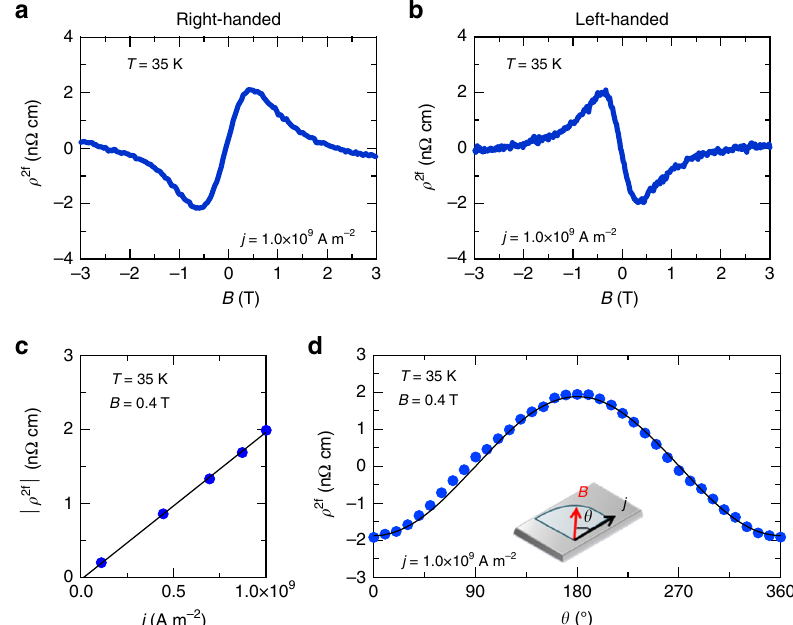
Fig. 2 Electrical magnetochiral effect in MnSi thin plate samples. a , b Magnetic fi eld dependence of second harmonic resistivity ( ρ 2f ) in right-handed a and left-handed MnSi crystals b . c , d Current-density ( j ) dependence of ρ 2f c and angle ( θ ) dependence of ρ 2f d in left-handed MnSi. Here θ is the angle between current and the magnetic fi eld as shown in the inset of d . The solid line is fi t to cos